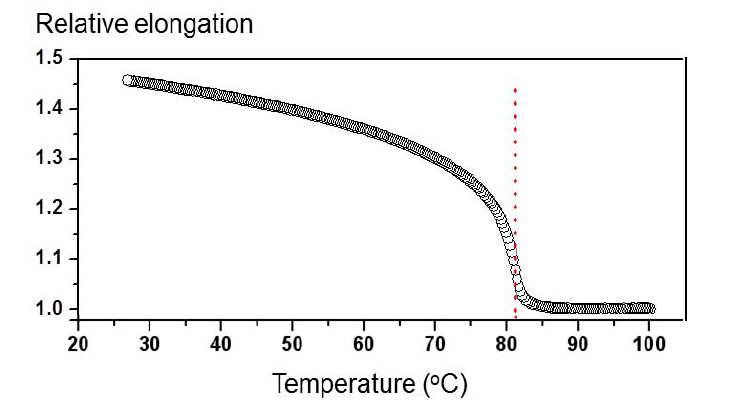
Figure 1. Relative spontaneous elongation of the sample as a function of temperature measured in the absence of UV illumination. The dotted line indicates the temperature maximum of ( dL / dT ), which is considered as the transition temperature from the nematic to the paranematic